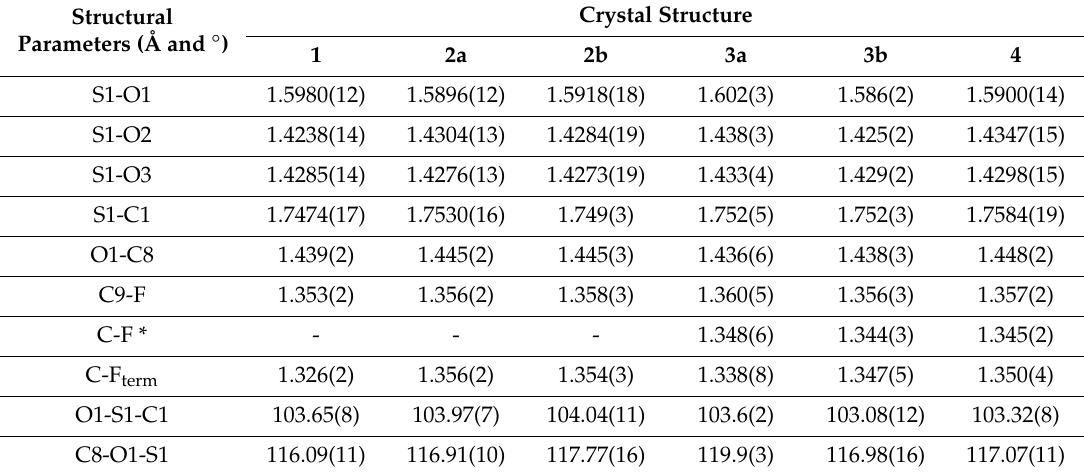
Table 1. Selected bond lengths and angles in 1–4 .